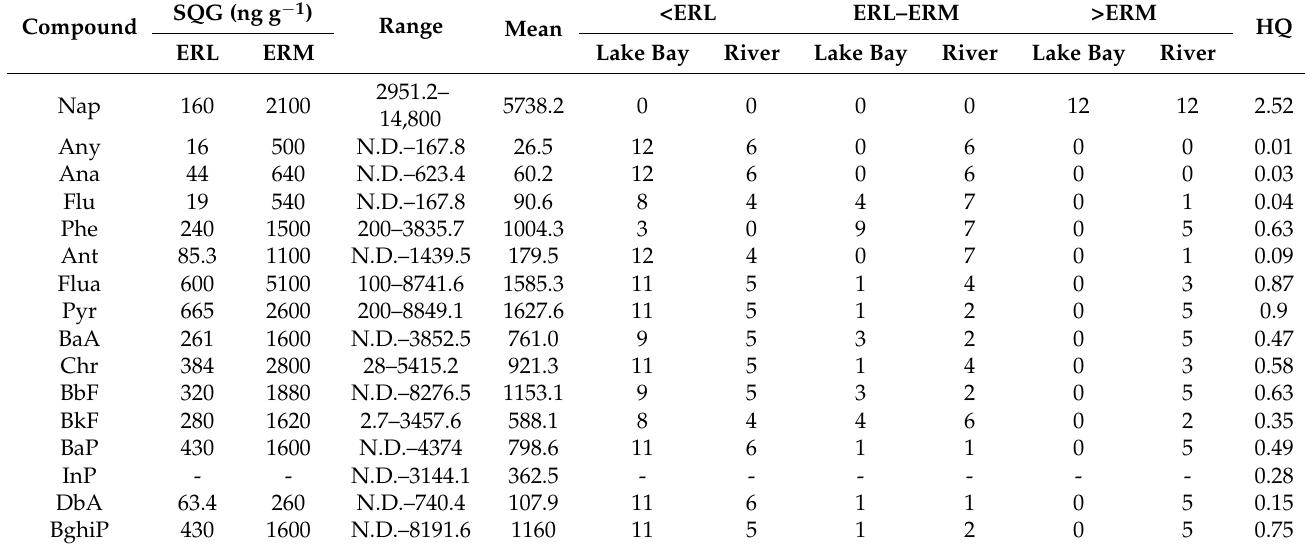
Table 3. Toxicity risk assessment for surface sediments from studied lake bay and adjoining river using Sediment Quality Guidelines (SQGs) and Hazard Quotient